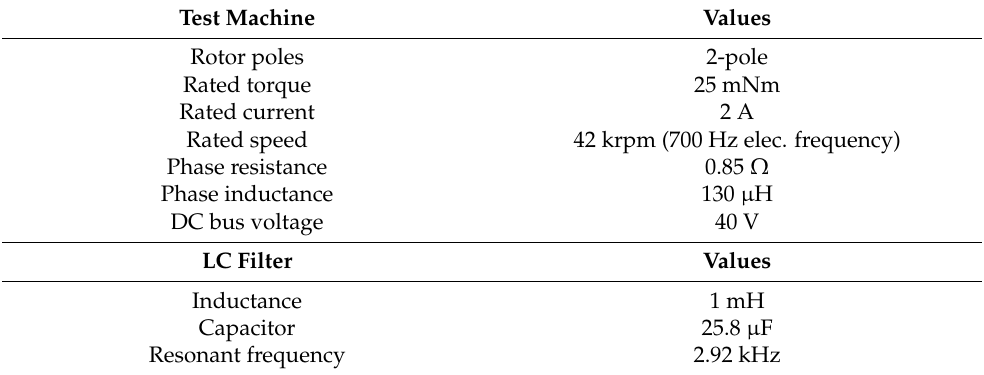
Table 1. Test PM machine characteristics.